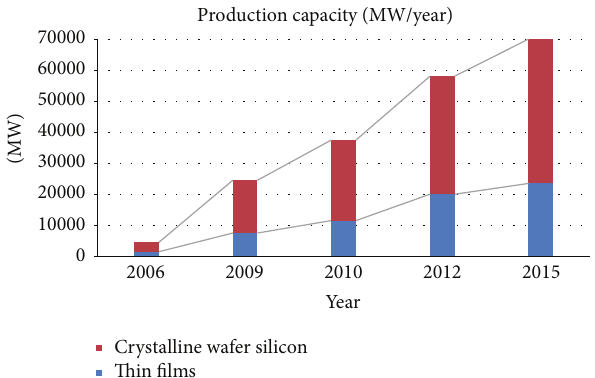
Figure 8: Annual PV production capacities of thin-film and crystalline silicon-based solar modules [18].